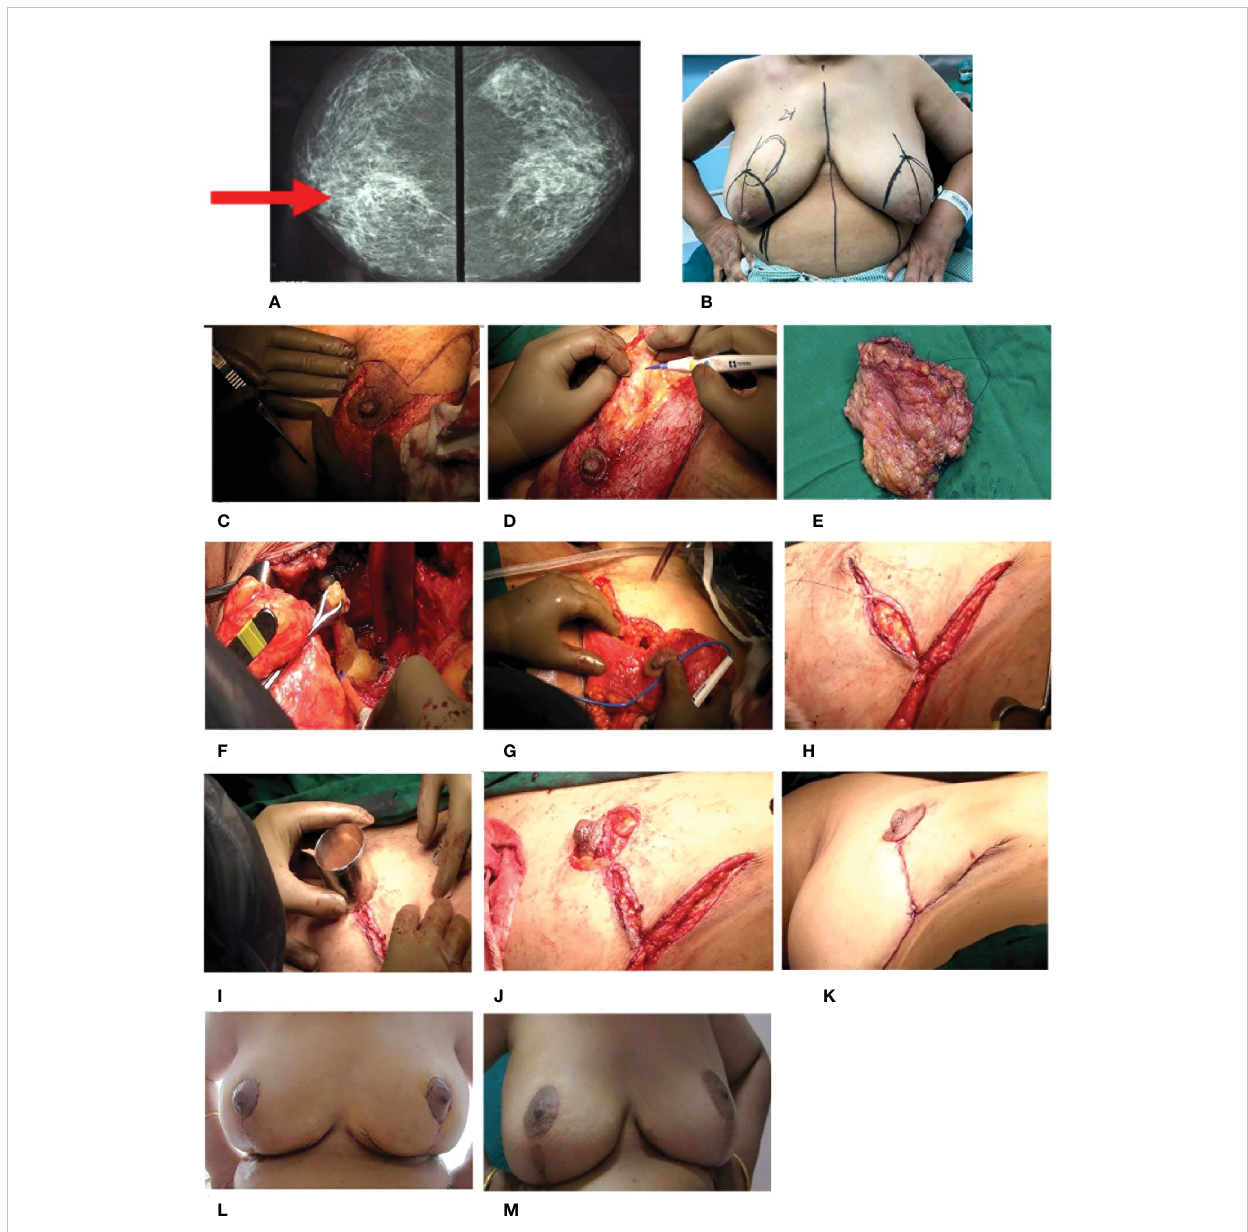
FIGURE 6 Complex TM. (A) Pre-operative radiology image: craniocaudal view of both breasts. Ill-de fi ned radiodensity with spiculations and surrounding architectural distortion is seen in the deep central quadrant of the right breast. Pleomorphic amorphous microcalci fi cation is also seen. (B) Markings for Wise pattern incision of the right with the tumor and contralateral breast for symmetrization. (C – K) Intra-operative images. (C) De-epithelialization of the inferior pedicle. (D) Excision of the tumor. (E) Excised tumor specimen. (F) Sentinel node biopsy. (G) Extended inferior pedicle to fi ll the defect. (H) Re-structuring of the breast. (I) Marking of the future nipple – areolar complex (NAC). (J, K) Re-structured breast with the fi nal outcome. (L, M) Post-operative images. (L) One-month follow-up. (M) Annual follow-up. TM, therapeutic